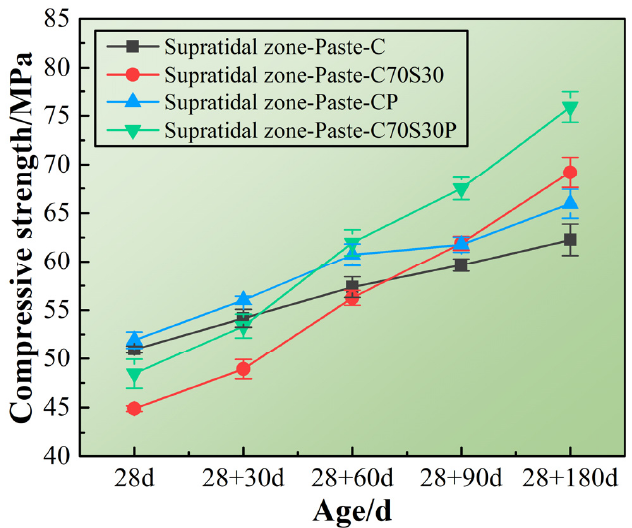
Figure 5. The mechanical properties of CBRM-Pastes serving in the supratidal zone simulated envi- ronment.